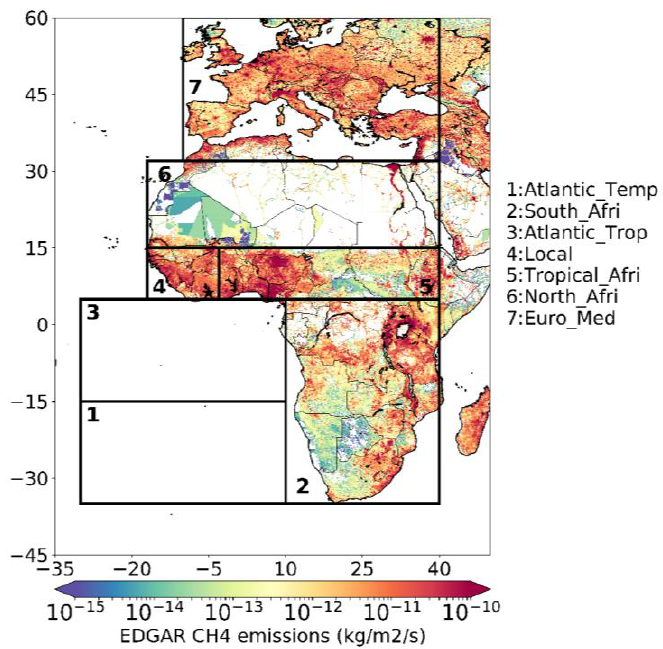
Figure 6. Regions selected for dimension reduction prior to the application of the clustering algorithm. Anthropogenic CH 4 emissions for 2015 from the EDGAR v5.0 database with a spatial algorithm. All main anthropogenic sources, e.g., waste treatment, industrial and agricultural sources, are included. Selected regions were: Temperate Atlantic (here Atlantic_Temp); South Africa (here South_Afri); Atlantic Tropical (here Atlantic_Trop); local; Tropical Africa (here tropical_Afri); North Africa (here North_Afri); Europe-Mediterranean (here Euro_Med). The star (in black) in the local area indicates the sampling location.